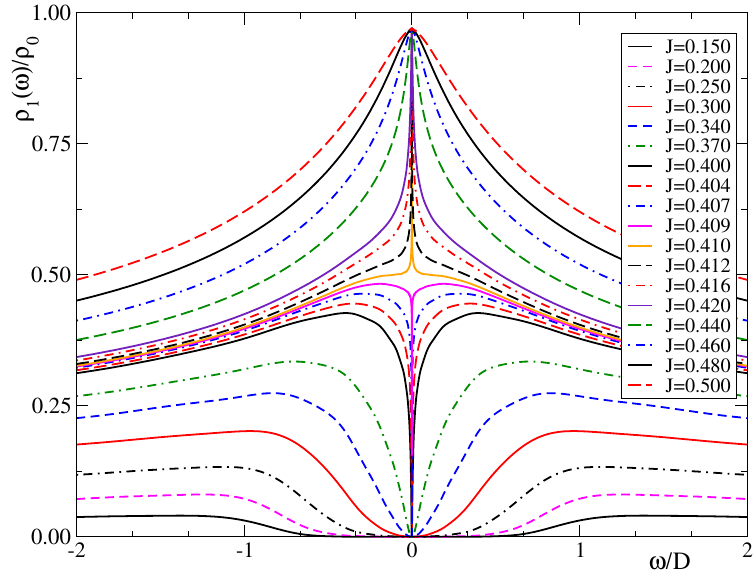
Figure 1: Normalized spectral density of the A2CS1KM as a function of frequency for D = 0.042 W and several values of the Kondo coupling J , given in units of the half band with W of the conduction